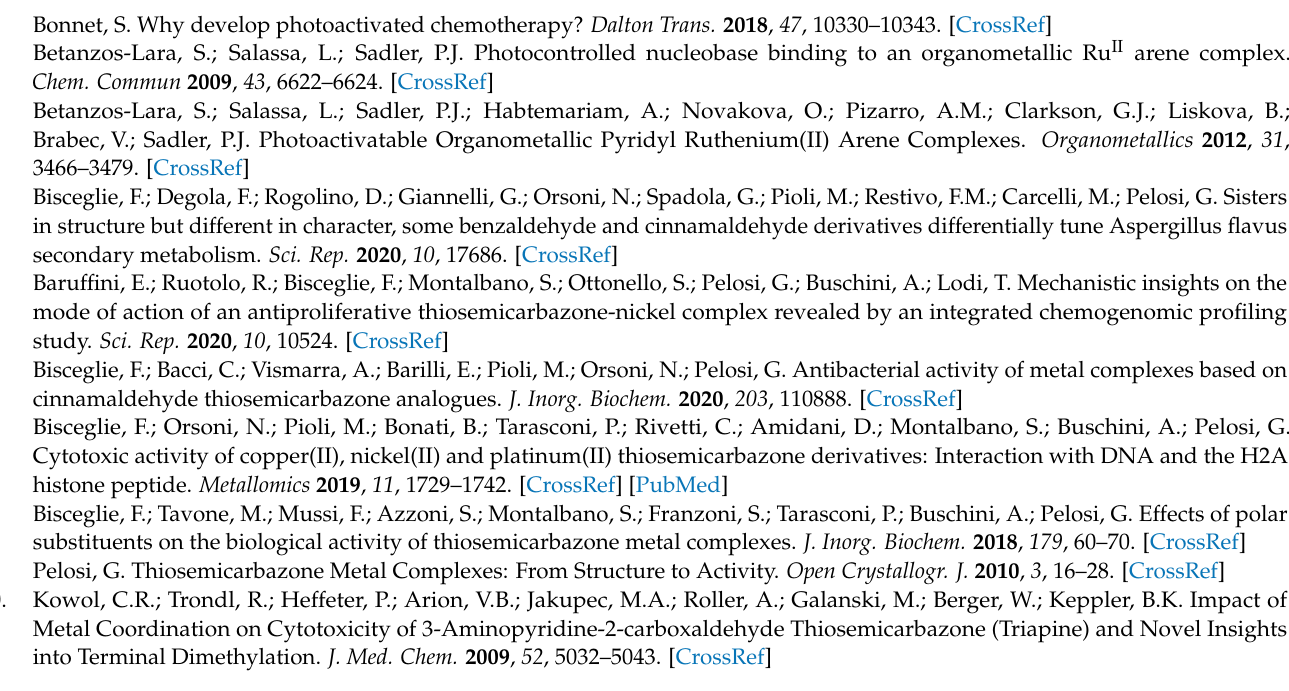
immediately after the sample preparation (blue line) and after 24 h (red line), Figure S2. Photo-oven used for the photoactivation experiments, Figure S3. UV-titration of C with copper(II) chloride, Figure S4. UV-titration of C with nichel(II) chloride, Figure S5. UV-titration of L’ with copper(II) chloride, Figure S6. UV-titration of L’ with nichel(II) chloride, Figure S7. Comparison of the 1H-NMR spectrum of the complex C after 8 h of irradiation with the spectra of the pure [( η 6-p-cym)Ru(N,N- bipy)(DMSO)] and the pure free pro-ligand, Figure S8. Suggested structure of the hetero-dinuclear complexes, Figure S9. 1H-NMR IC1 in CDCl3, Figure S10. 13C-NMR IC1 in CDCl3, Figure S11. 1H- NMR IC2 in CD6CO, Figure S12. 13C-NMR IC2 in CD6CO, Figure S13. 1H-NMR IC3 in DMSO-D6, Figure S14. 13C-NMR IC3 in CD6CO, Figure S15. 1H-NMR C in DMSO-D6, Figure S16. 13C-NMR C in CD6CO, Figure S17. Full HR-MS of IC1, Figure S18. Full HR-MS of